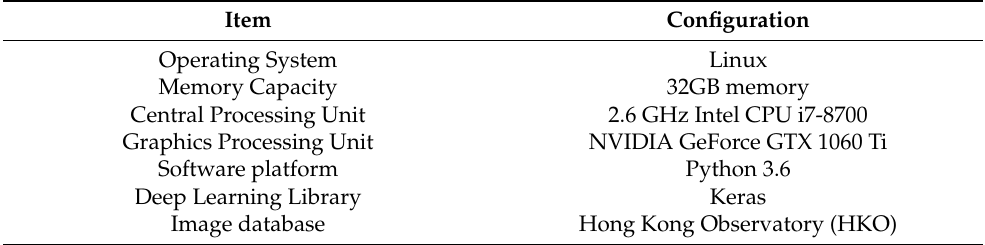
Table 2. The hardware and software parameters of the server.